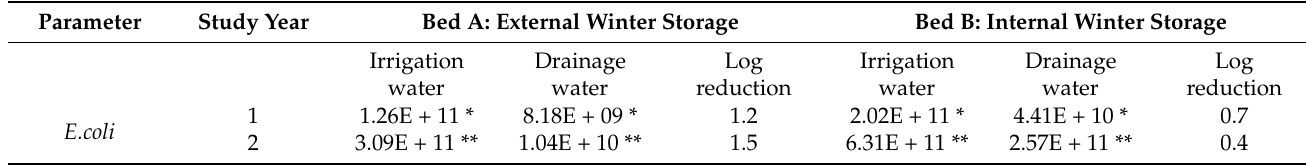
Table 3. Cumulative E. coli in the irrigation water, drainage water and their removal recorded for both study years within the